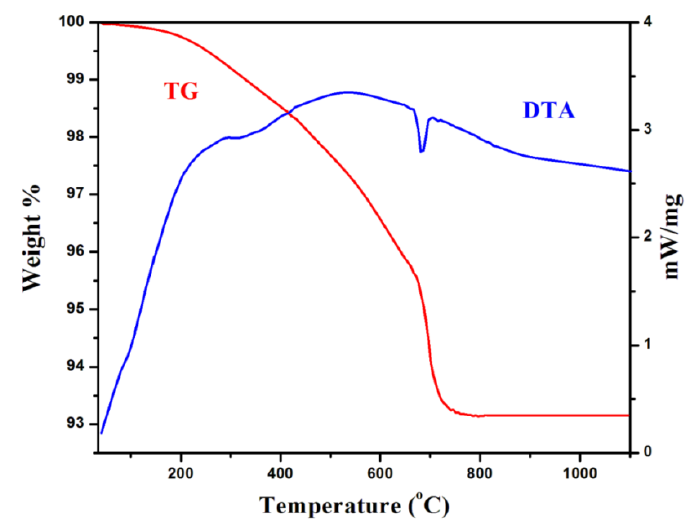
Figure 1. TG-DTA pattern of as-prepared gadolinium orthoferrite.